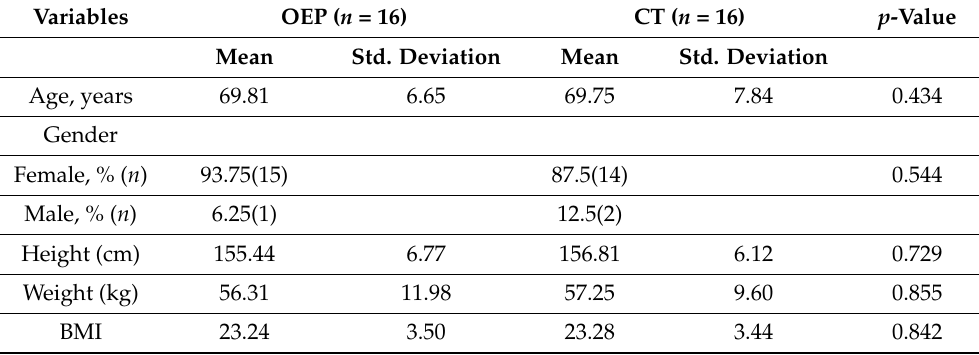
Figure 1. CONSORT flow diagram displaying cluster randomized clinical trial participant pathways through the 12 weeks study. OEP = Otago Exercise Program. Table 1. Demographic characterization of modified-Otago Exercise Program (OEP) and control groups at